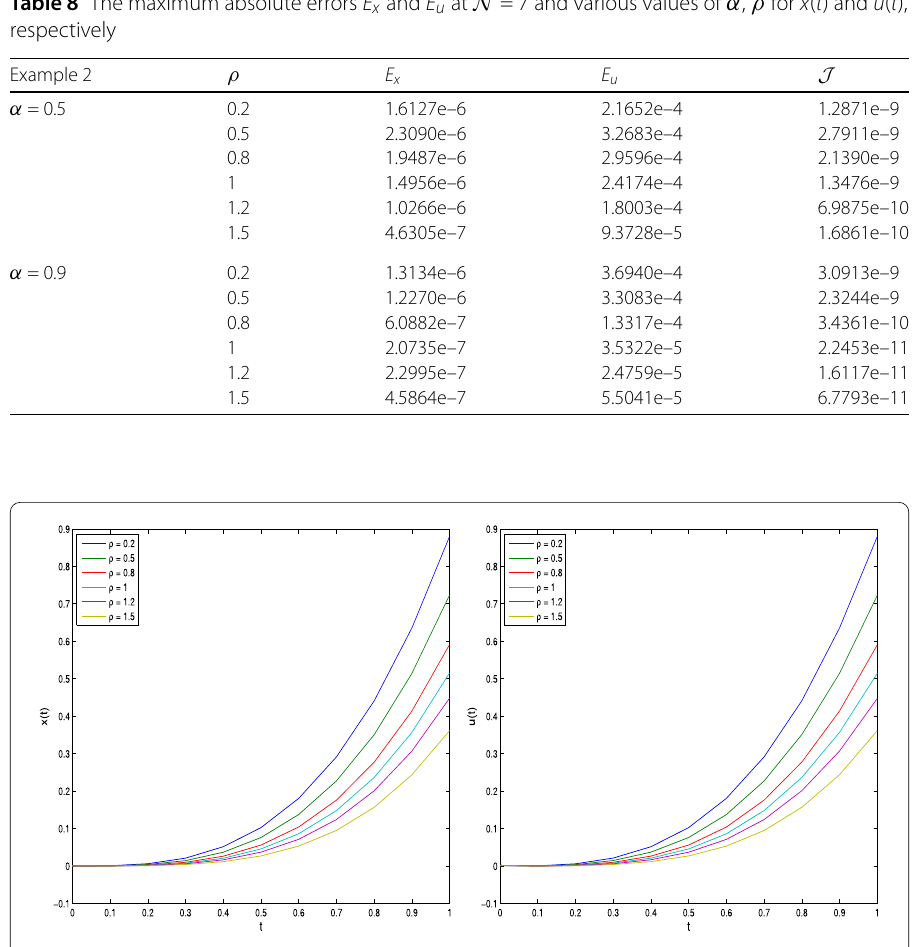
Figure 4 The approximate state x ( t ) (left) and the approximate control u ( t ) (right) at various values of ρ and α = 0.5, N = 5